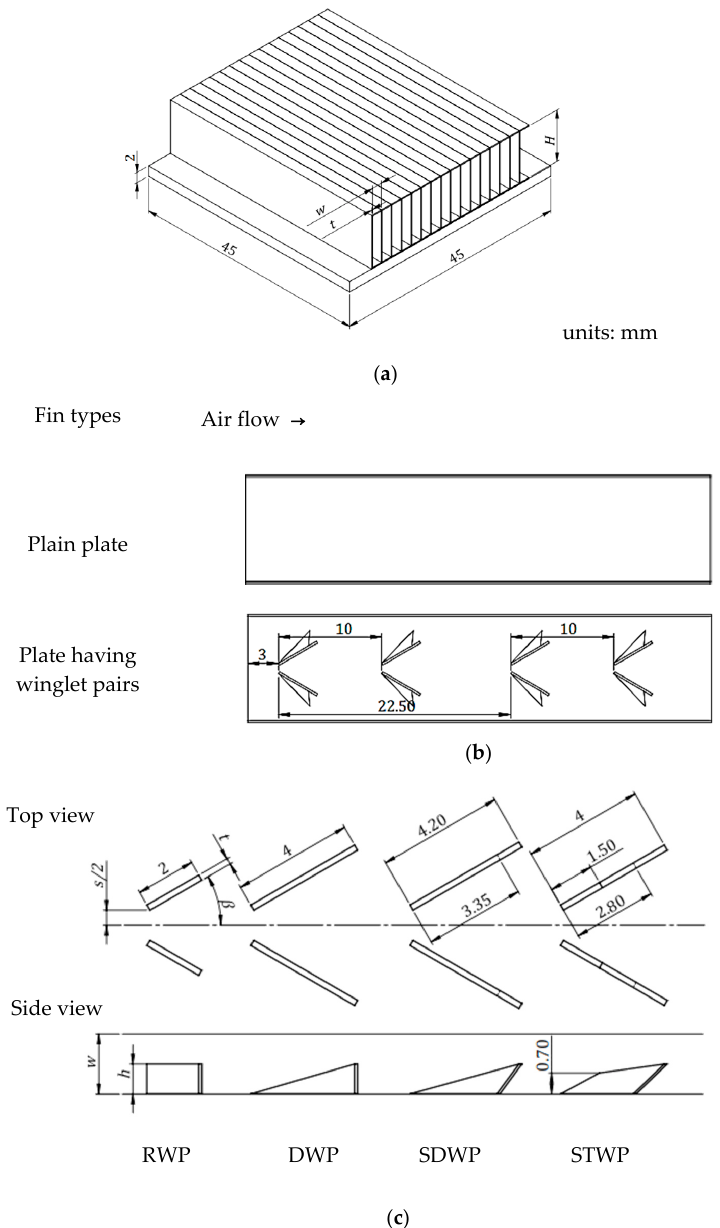
Figure 2. Tested heat sinks; ( a ) the exterior dimensions, ( b ) the arrangement of the four rows of winglet vortex generators (VGs), and ( c ) types of tested winglet VGs.